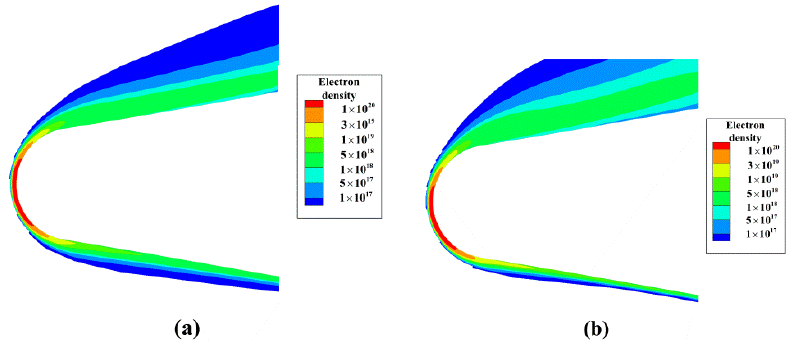
Figure 4. The electron density distribution in scenes 6 and 7. ( a ) Attack angle is 10°. ( b ) Attack angle is 20°.